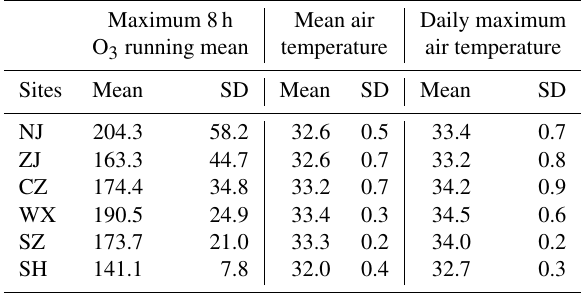
Table 1. Averages (mean) of maximum 8h running mean surface O 3 concentrations (µgm − 3 ), mean air temperature ( ◦ C) over the periods of maximum 8h running mean surface O 3 concentrations and daily maximum air temperature ( ◦ C) with their standard devi- ations (SD) over the 22–25 August 2016 period observed at the NJ site in the western